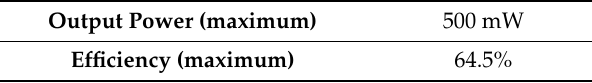
Table 4. Specific characteristics of the dual-stage circuit.